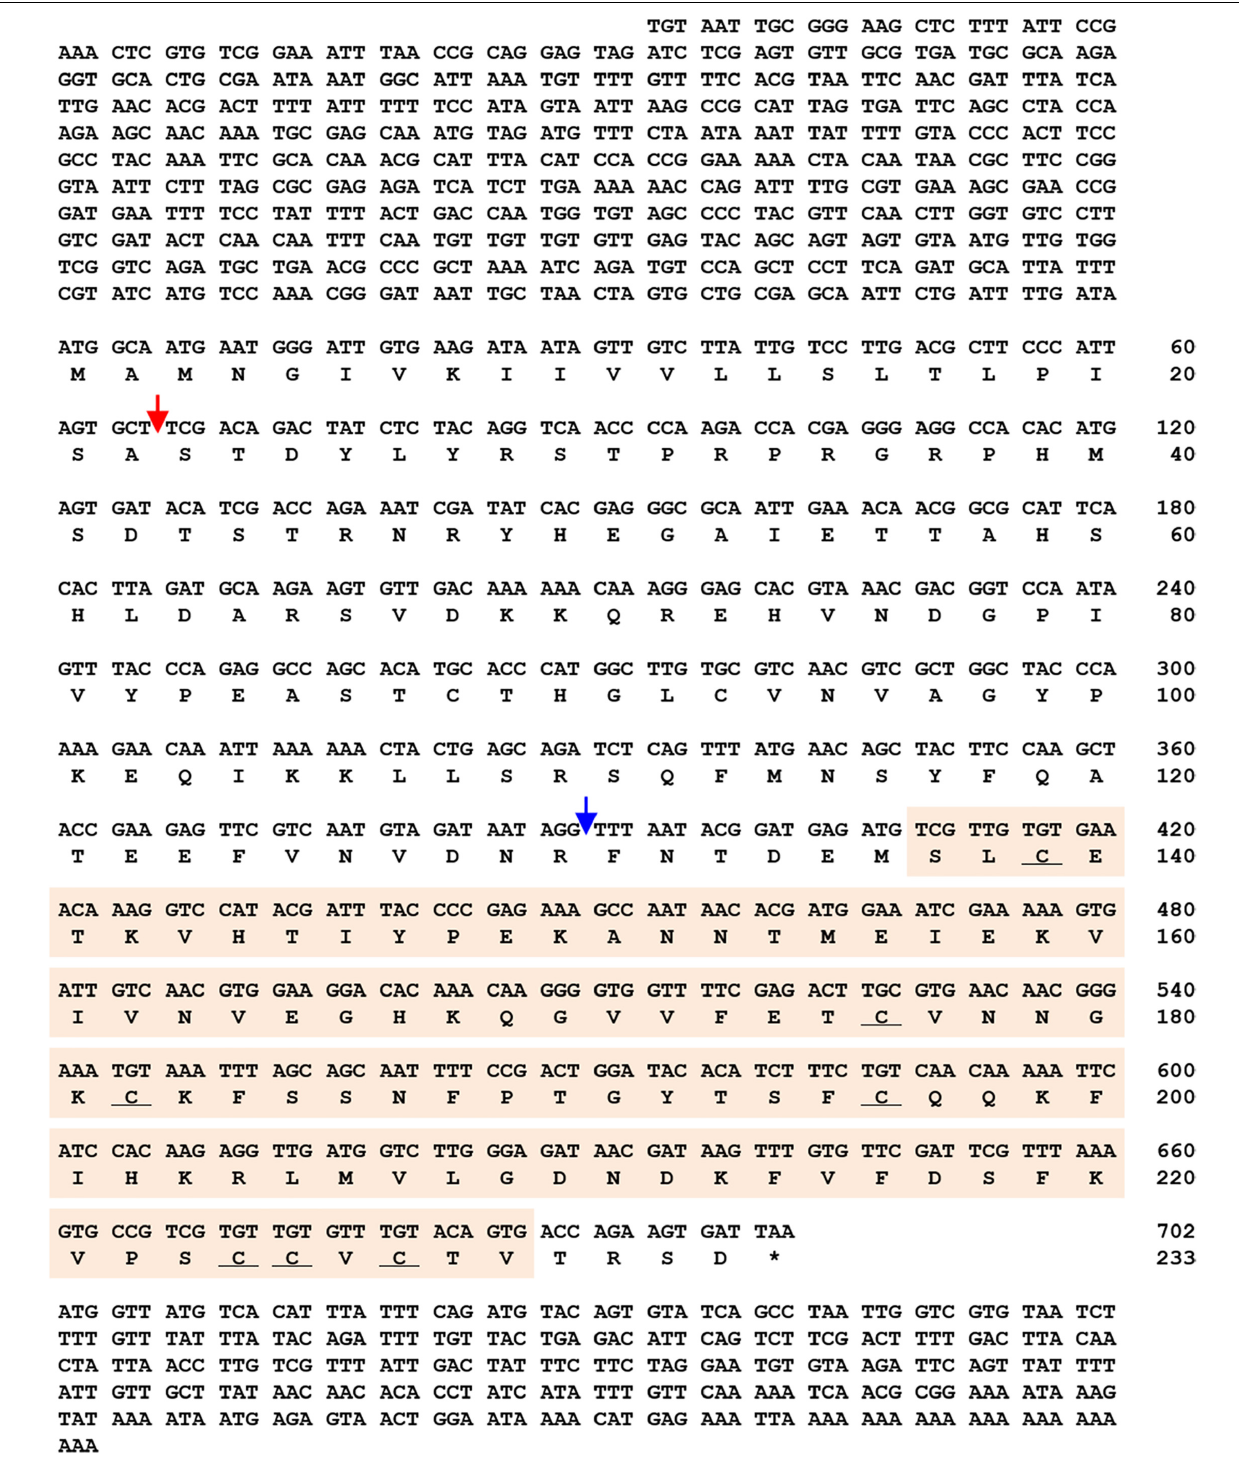
FIGURE 1 | Nucleotide and deduced amino acid sequences of TmSpz1b . TmSpz1b includes an ORF sequence of 702 bp encoding a polypeptide of 233 amino acid sequences. The 5 (cid:48) - and 3 (cid:48) -UTRs are 627 bp- and 276 bp long, respectively, excluding the poly-A tail. A polyadenylation signal sequence (5 (cid:48) -AATAAA-3 (cid:48) ) is marked with blue text. Nucleotides and amino acids are numbered on the right of the sequences. * Denotes stop codon. Domain analysis of Tm Spz1b revealed a C-terminal cystine-knot domain (orange box), a signal peptide region (cleaving site between amino acids 22 and 23, red arrow), and a putative cleavage site (blue arrow). Seven conserved cystine residues (underlined) are located in the cystine-knot domain.